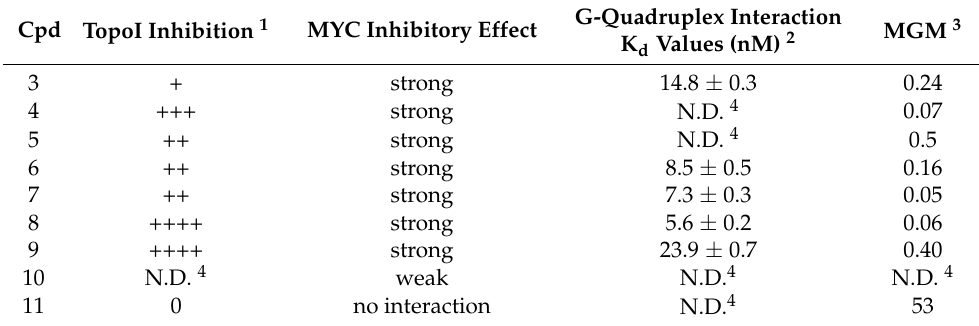
Table 2. Summary of the biological activities of indenoisoquinolines 3 – 11